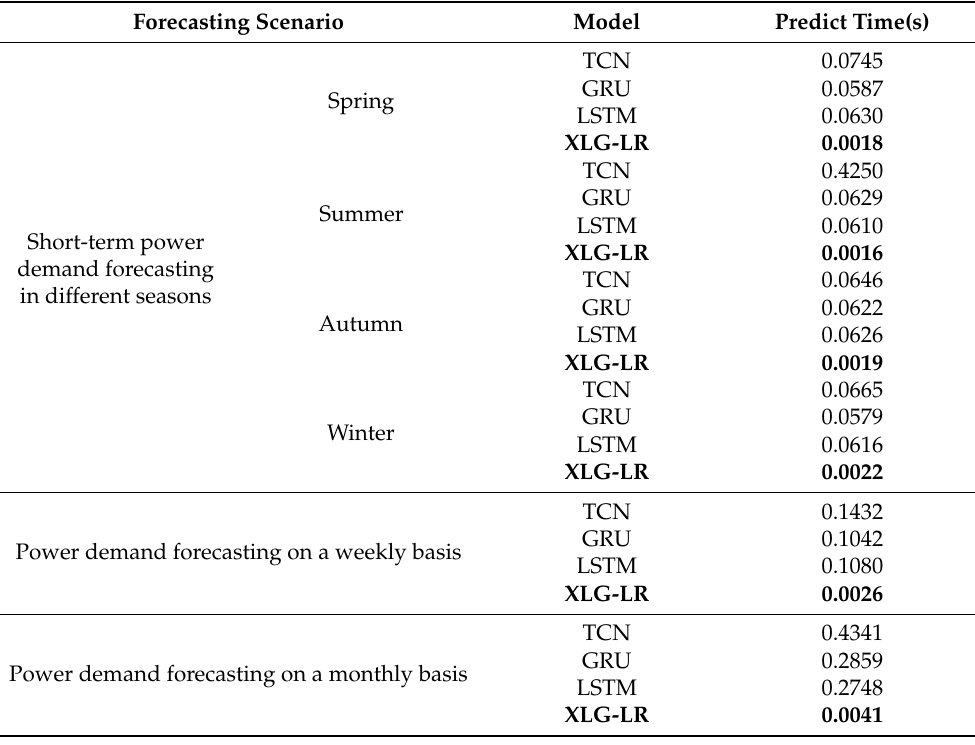
Table 10. The Time Required for Power Demand Forecasting of Different Models in Different